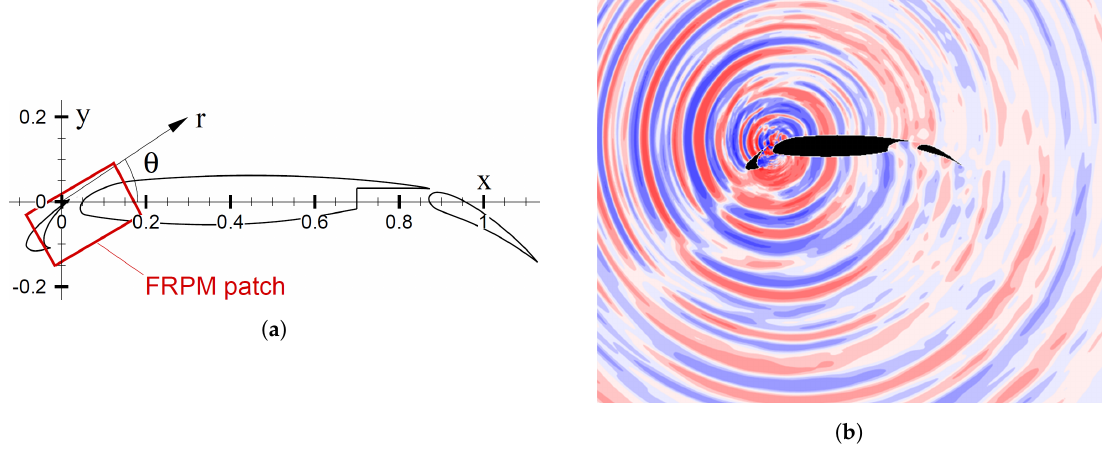
Figure 3. Typical computation setup for CAA simulation of slat noise and results of the pressure distribution. ( a ) Arrangement of fRPM (fast Random Particle Mesh Method) source patch (red box); ( b ) Snapshot of acoustic pressure (red=positive fluctuation, blue=negative